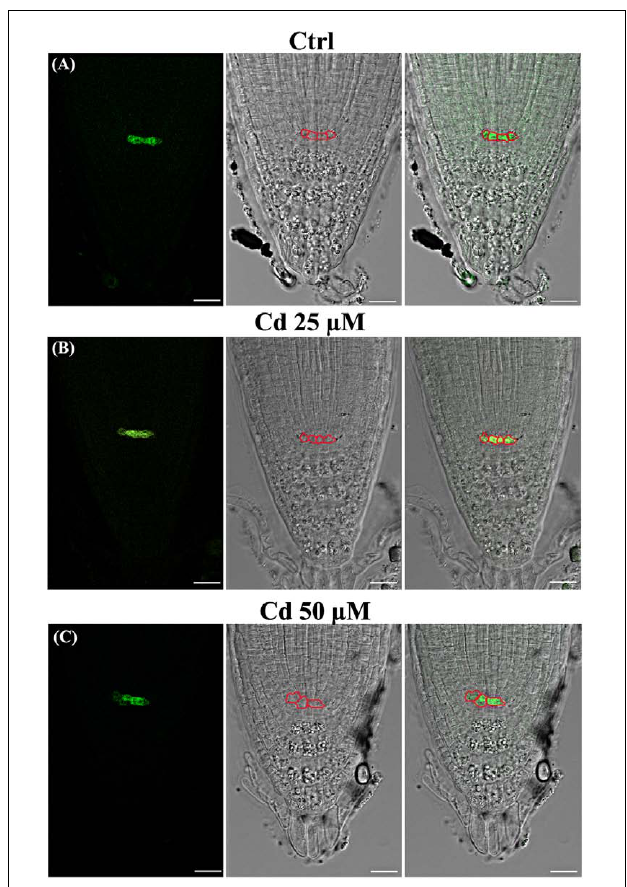
FIGURE 4 | Images of primary root tip in seedlings of A. thaliana pWOX5::GFP transgenic line germinated (A) on growth medium as control (Ctrl) and on medium added with (B) 25 and (C) 50 µ M Cd for 8 days after germination. From left to right: confocal laser image; transmission image; merged image. Boxed cells expressing GFP signal identify QC cells. Scale bars 23 µ